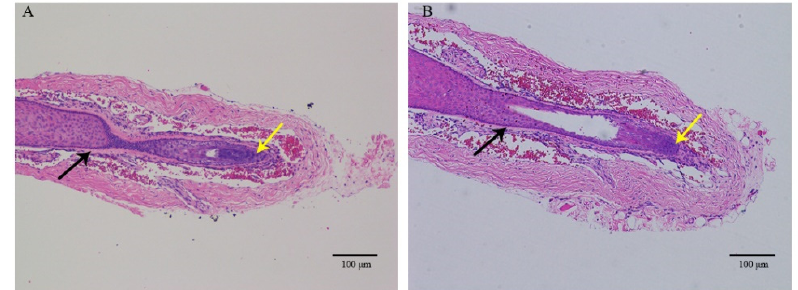
Figure 1. The combined treatment of IGF-1 and EGF regulates hair follicle growth. ( A1 – A4 ) Images of whisker follicles for the control group at 0, 2, 4 and 6 days. ( B1 – B4 ) Images of whisker follicles for the combined treatment group at 0, 2, 4 and 6 days. ( C ) The combined treatment of IGF-1 and EGF increased the elongation length of hair shafts. For significance, ** p < 0.01.